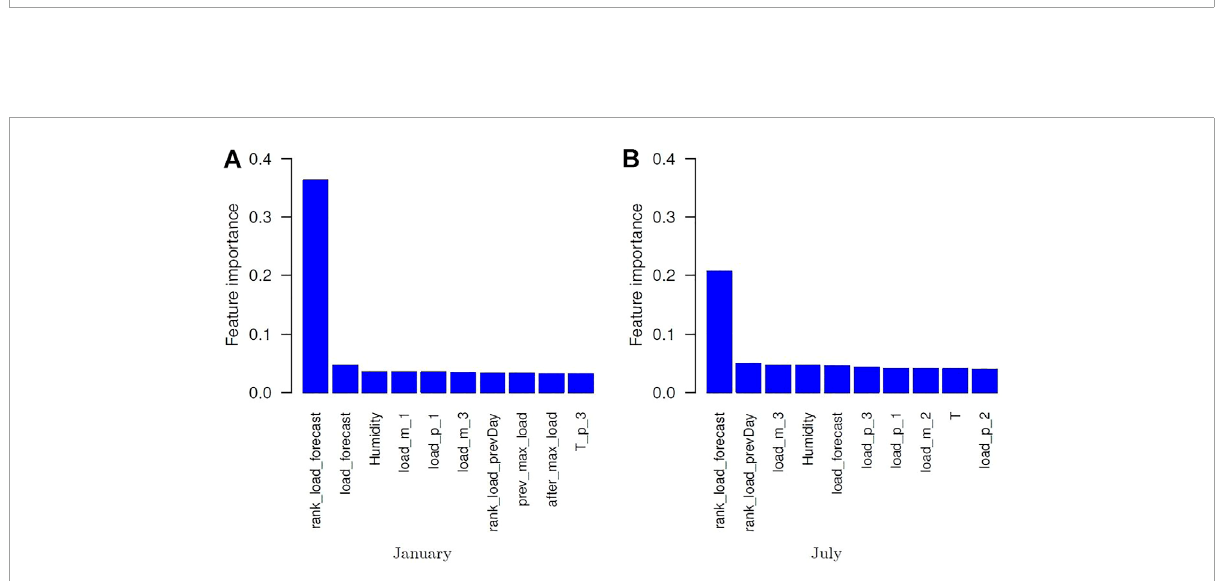
FIGURE 6 Feature importance of peak hour models for (A) January and (B)